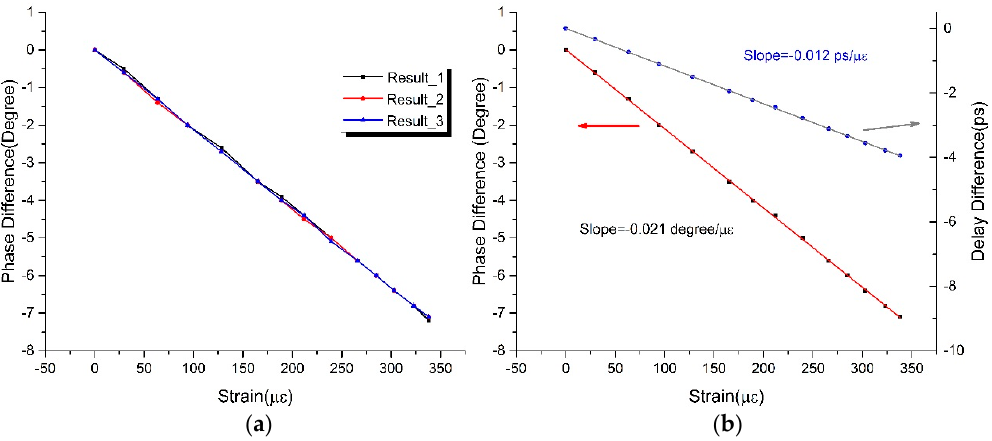
Figure 10. The experiments for testing the strain sensitivity of this sensor: ( a ) The repeatability response of phase difference under the same experimental conditions; ( b ) The response of degree and delay of this sensor with respect to a change in strain.